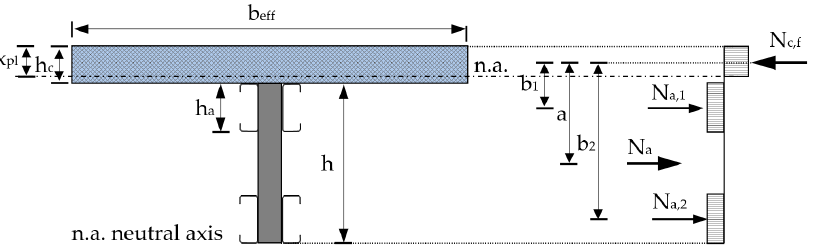
Figure 9. Cross-section of the analysed LWT-FLOOR beam.